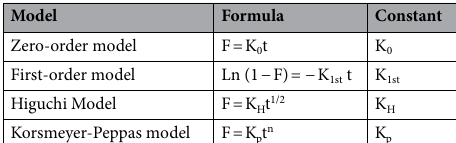
Table 3. Kinetic models applied on riboflavin release from R-Alg-AG beads.